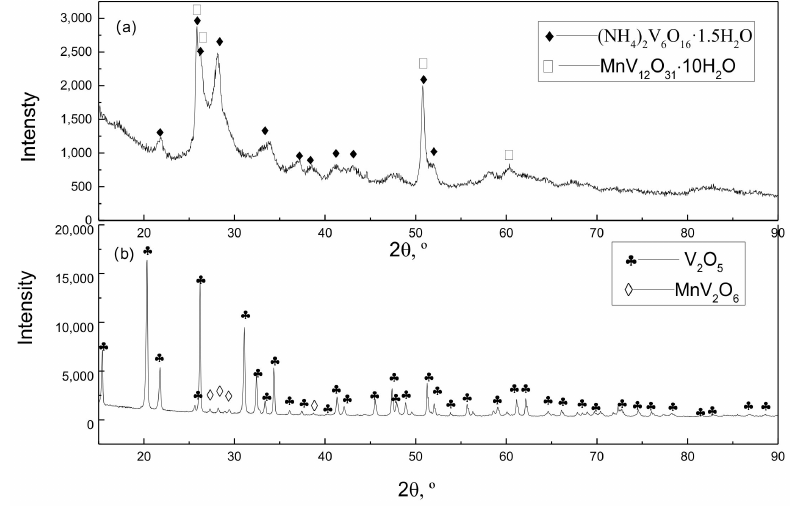
Figure 8. XRD pattern for products of vanadium precipitate ( a ) ammonium poly-vanadate; ( b ) vanadium pentoxide.